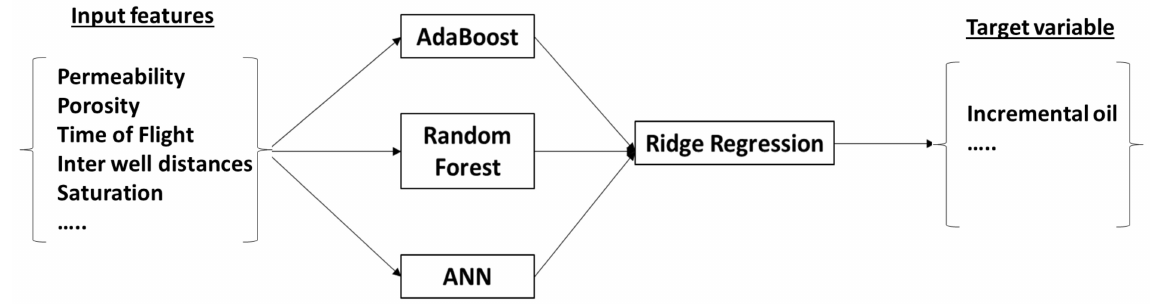
Figure 5. Schematic of the meta learner used for